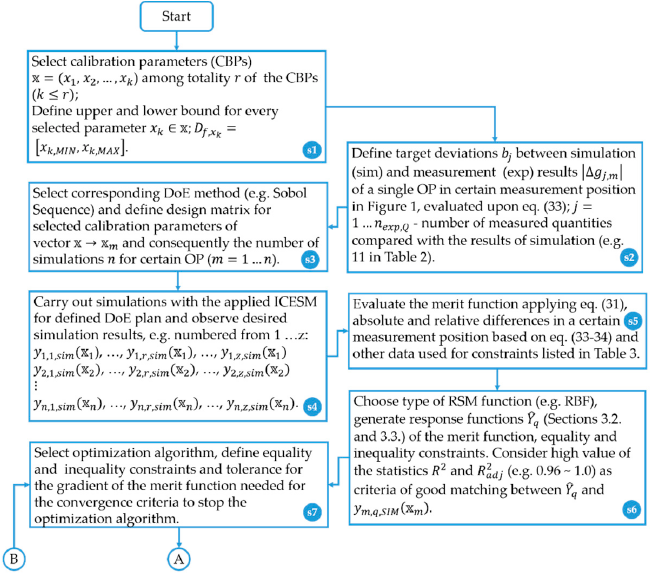
Figure A1. Flowchart for steps s1–s7 of CBP evaluation applying RSM ‐ based optimizations in one calibration loop.